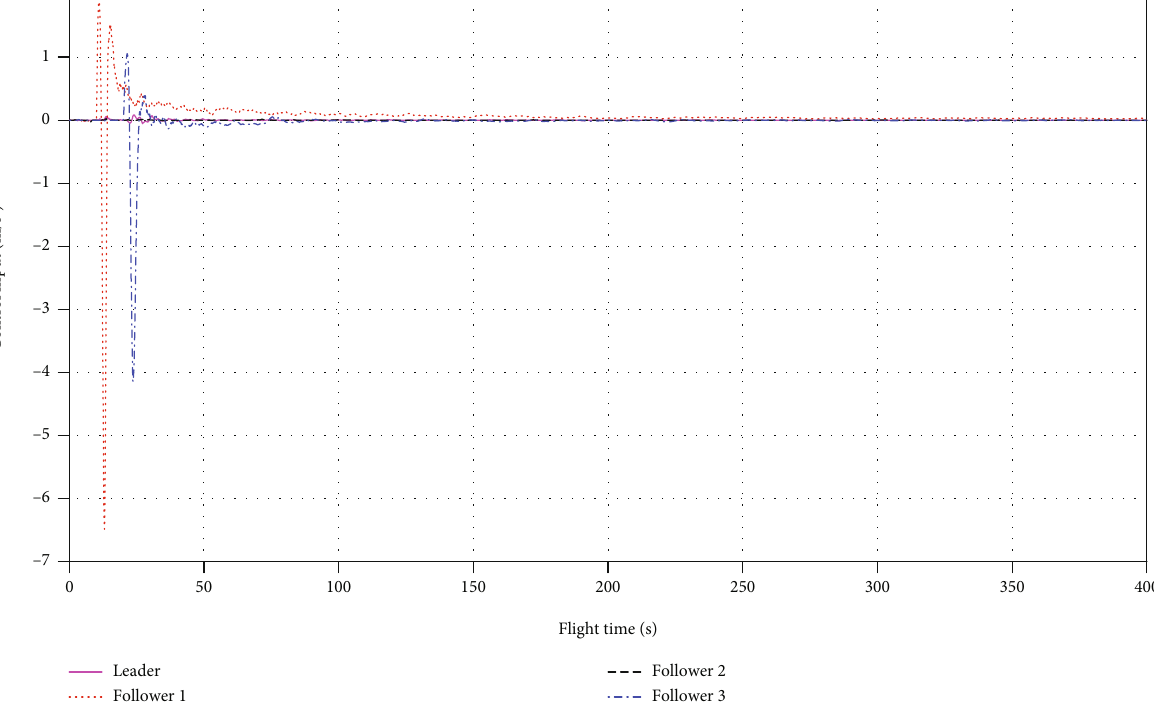
Figure 17: The control inputs for the UAV formation (without wind).